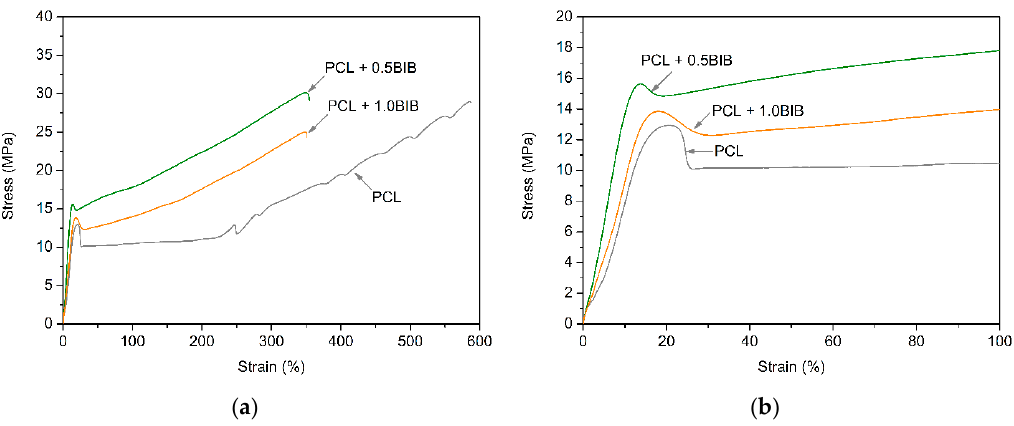
Figure 7. The stress–strain curves for PCL modified by DCP peroxide.